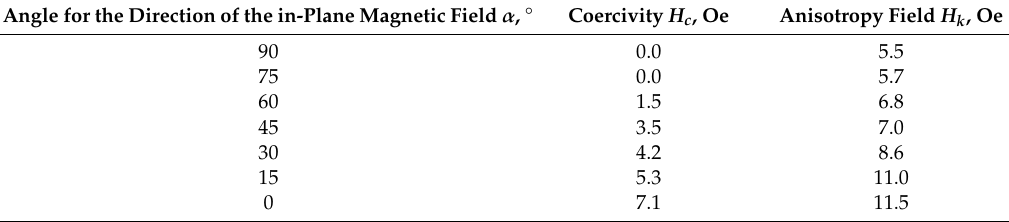
Table 2. Selected magnetic parameters of [Ti / FeNi] 6 / Ti / Cu / Ti / [FeNi / Ti] 6 multilayered GMI element, measured for di ff erent angles α between the in-plane applied external field H and easy magnetization axis oriented along the short side of the element (see also Figure